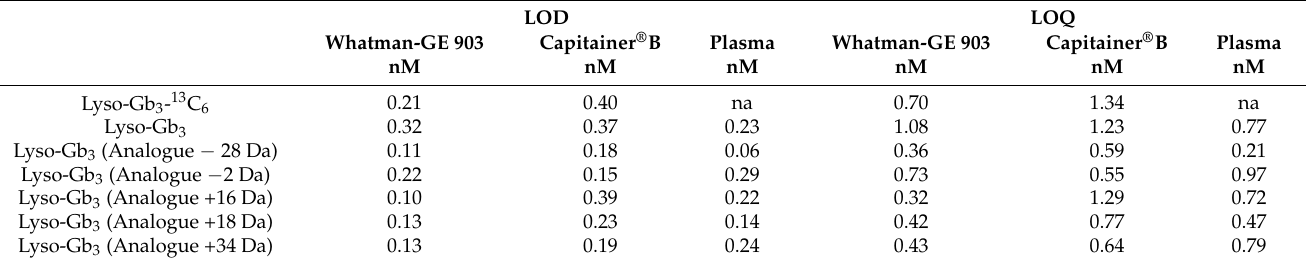
Table 5. Limits of detection (LODs) and limits of quantification (LOQs) for lyso-Gb 3 and its analogues in dried blood spots